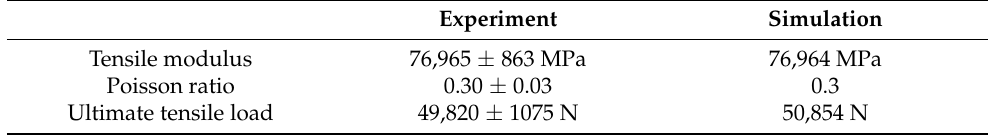
Table 7. Sample stiffness and strength check (0 ◦